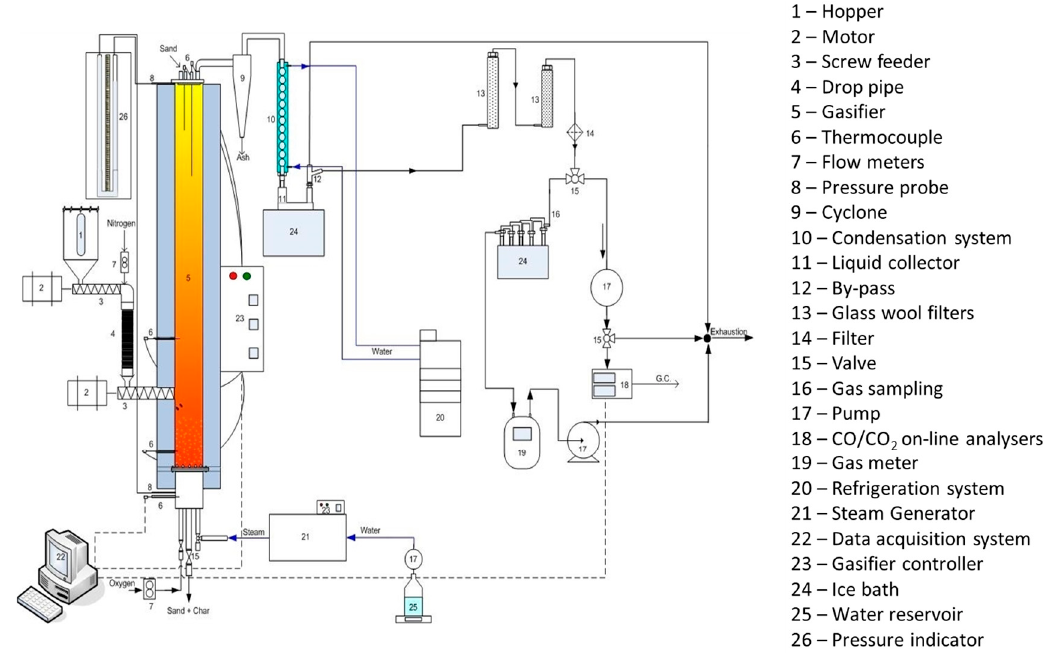
Figure 1. Schematic diagram of the bench-scale fluidized bed gasification system.